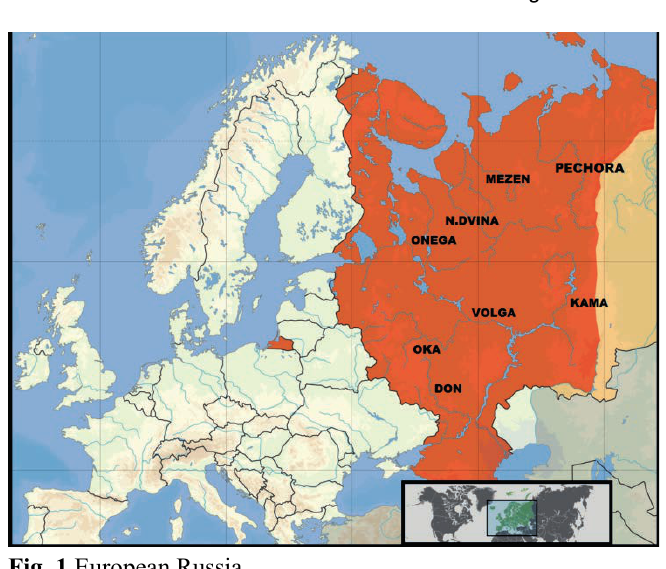
Fig. 1 European Russia